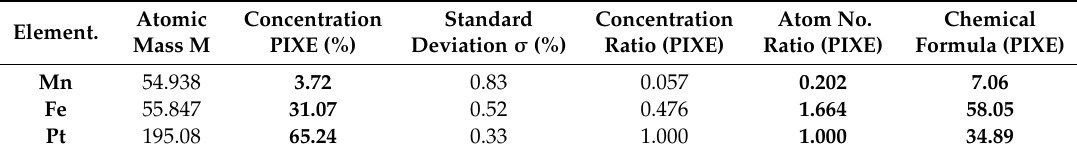
Table 1. PIXE results obtained on as-cast FeMnPt sample.